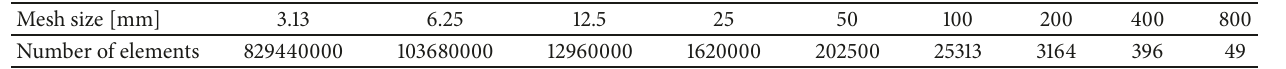
Table 6: 3D model mesh sizes and number of